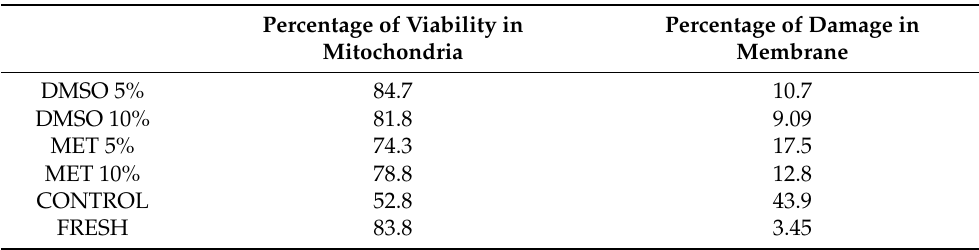
Table 4. Percentage of cell viability in Scenedesmus sp. on the first day after thawing, measured by flow